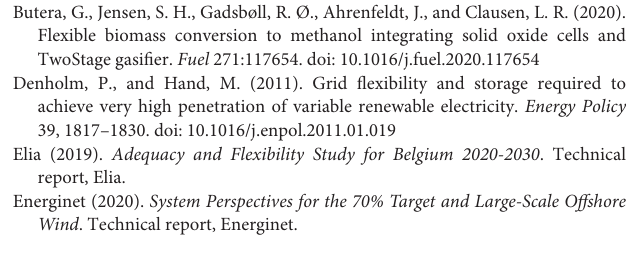
zones (DK1, SUD) and flexibility-need scenarios. The